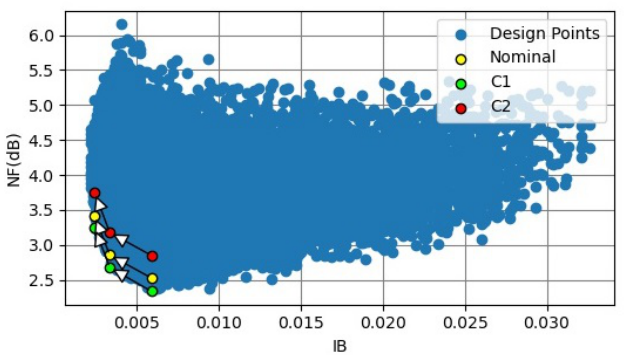
Figure 8. NF vs. total bias current (in Ampere) design space and optimal design points for the three corners: TT 27 ◦ C (Nominal), FF − 40 ◦ C (C1), and SS 125 ◦ C